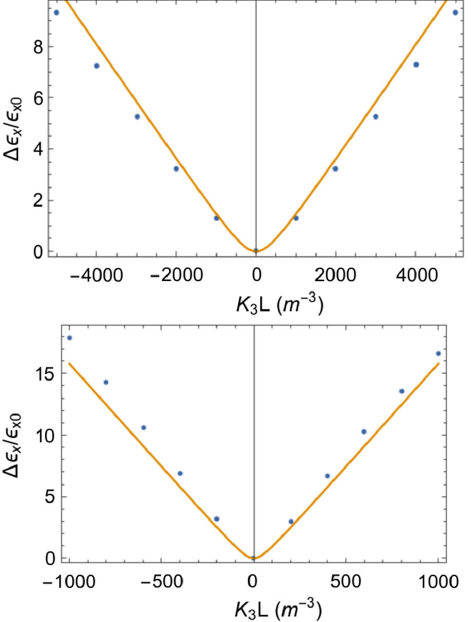
FIG. 3. Change in projected emittance with varying octupole strength from ELEGANT simulations considering an ideal beam with a linear chirp and Gaussian energy distribution (points) and the analytical expression from Eq. (9) (line) for the BC1 octupole (top) and BC2 octupole